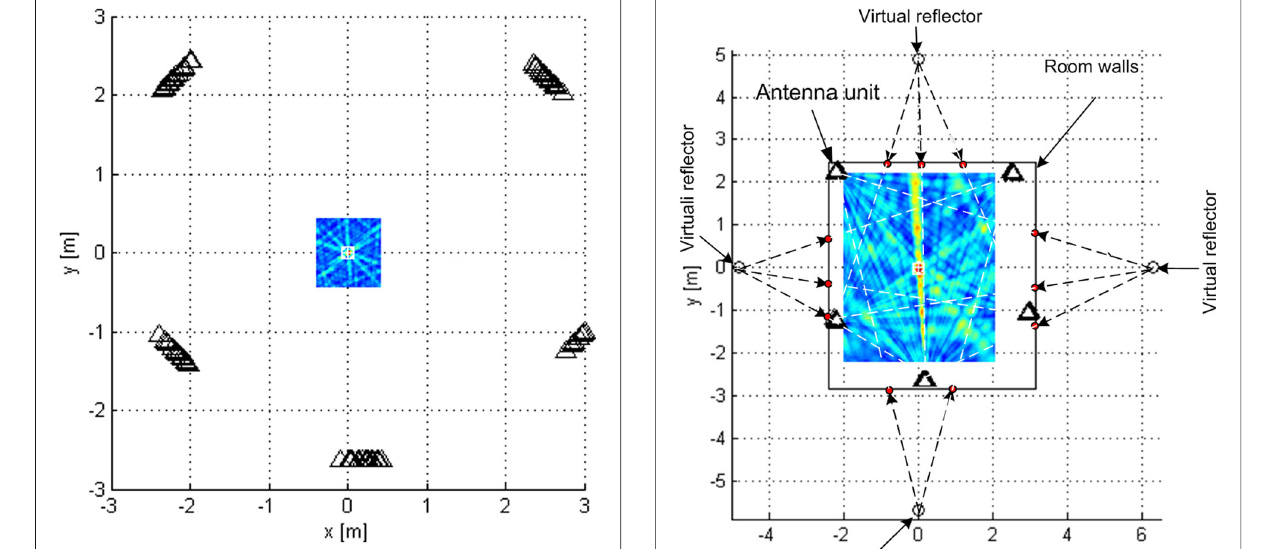
Fig. 9 Criterion function of stage 2 for G 2 with N = 1024